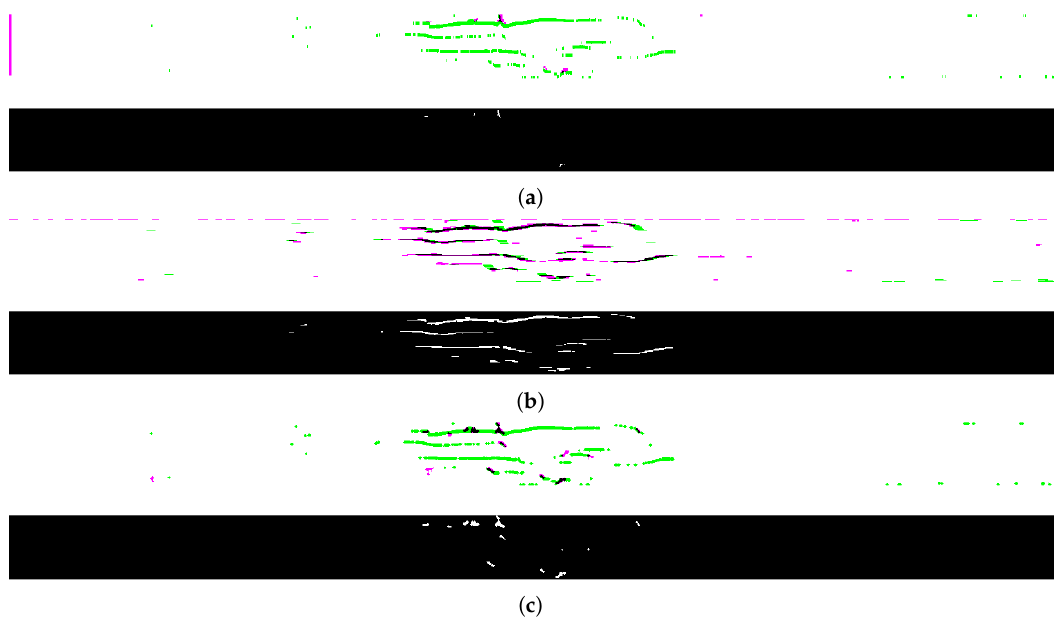
Figure 12. Recognized cracks after masking using: ( a ) V mask: ( b ) H mask; ( c ) D